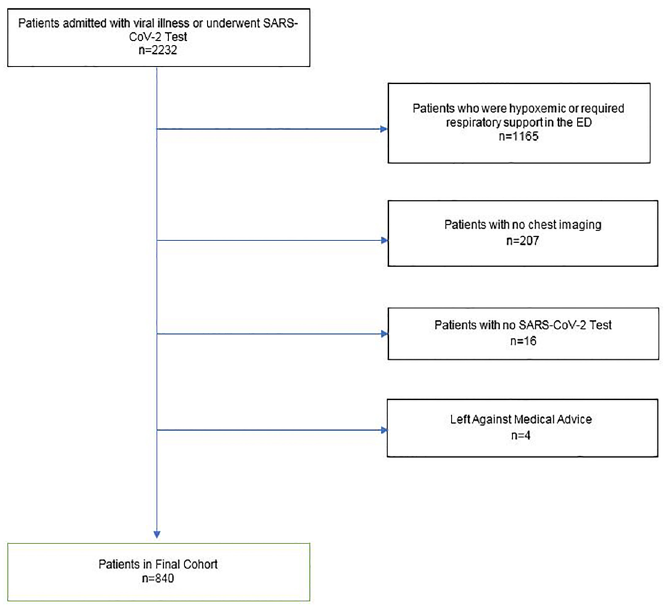
Figure 2. Enrollment